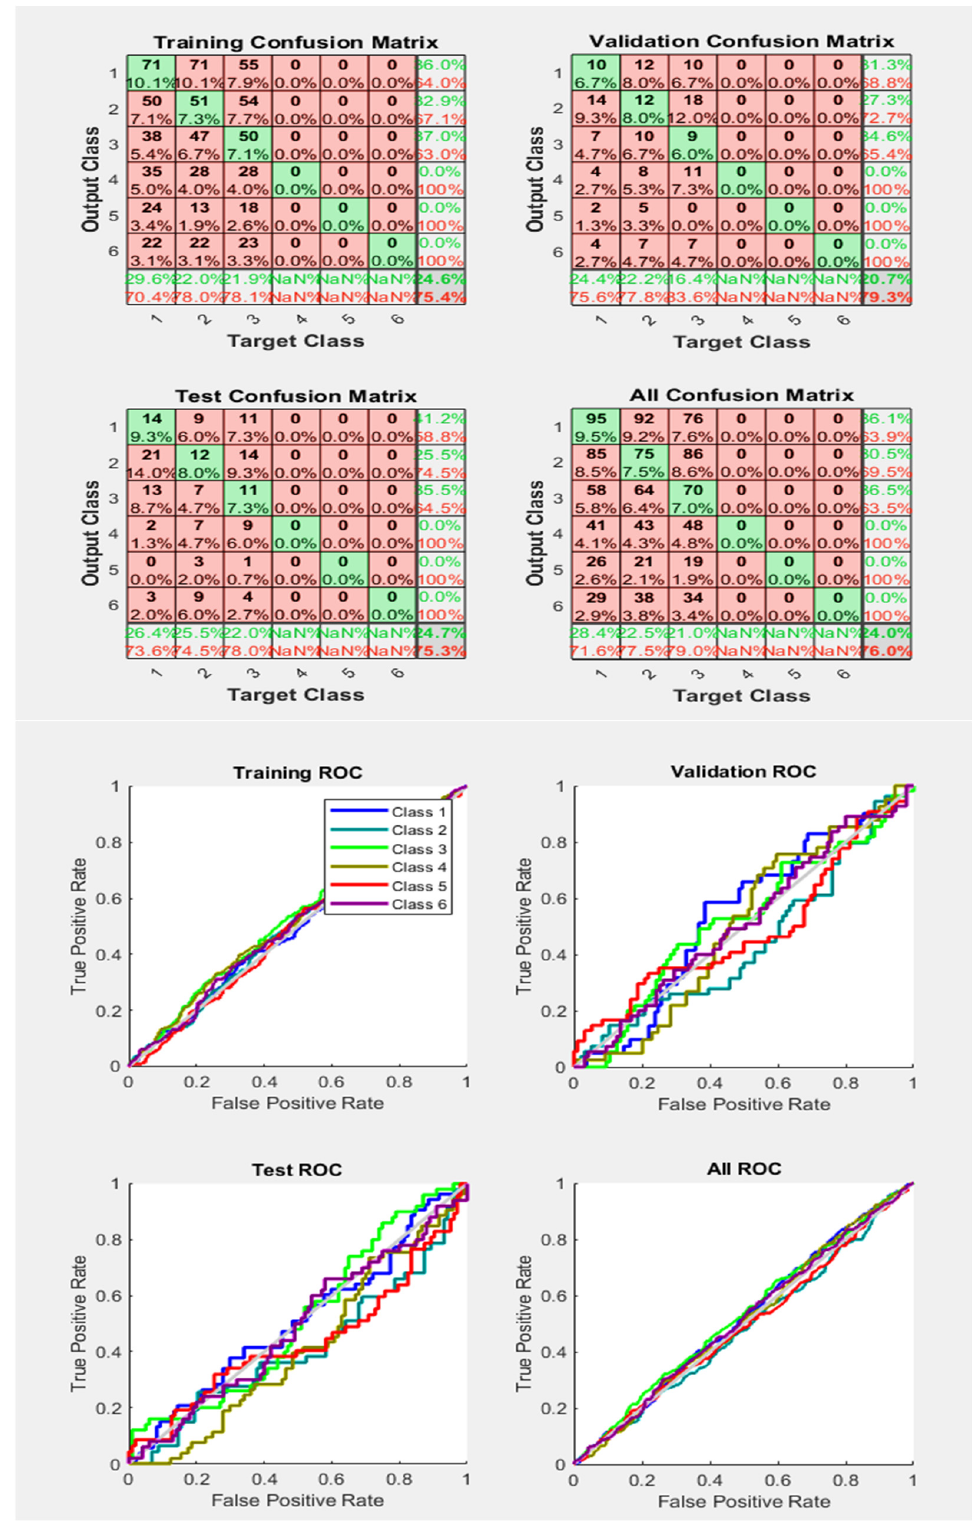
Figure 14. Neural Network Model ROC (Receiver Operating Characteristics) and Confusion Matrix for OSS Train Fcn/Activation Function at level 9 (RMS) Features for High Contact Resistance Fault with 76.0% Accuracy. Grey line shows diagonal of the ROC for indicating Class 1–6 lines are lying above or below or on it.